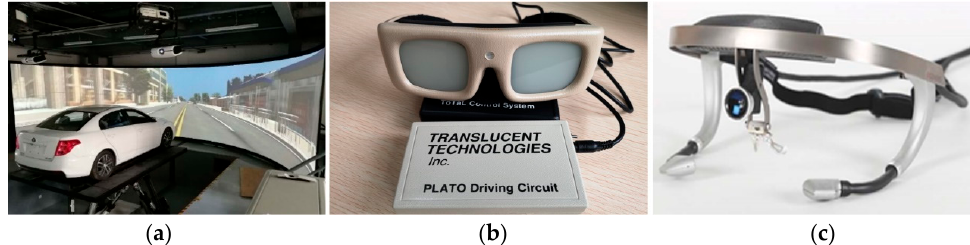
Figure 1. Experimental apparatuses in the experiment. ( a ) Driving simulator; ( b ) PLATO goggle; ( c ) Dikablis eye- tracker.